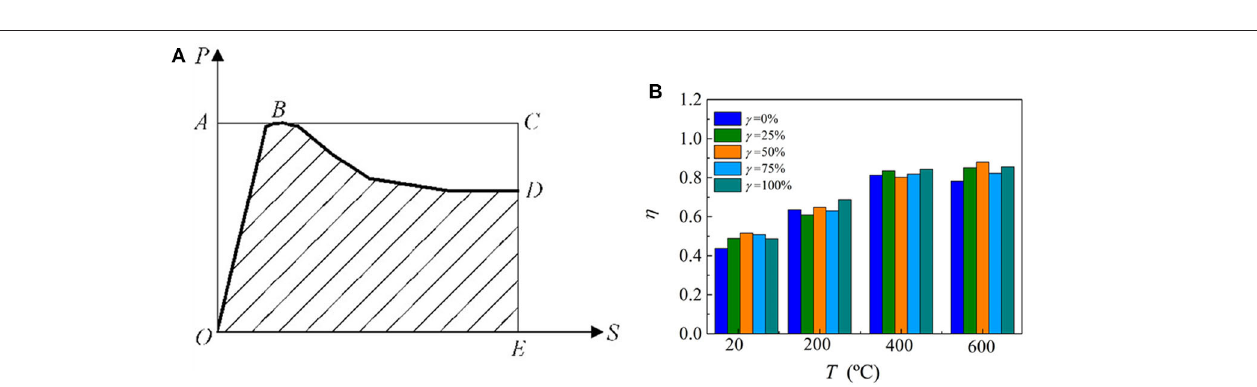
FIGURE 11 | Influence of elevated temperatures on interfacial bond failure: (A) elastic shear bond stiffness; (B) bond damage of specimens with 50% replacement percentage; (C) bond damage of specimens with 100% replacement percentage.